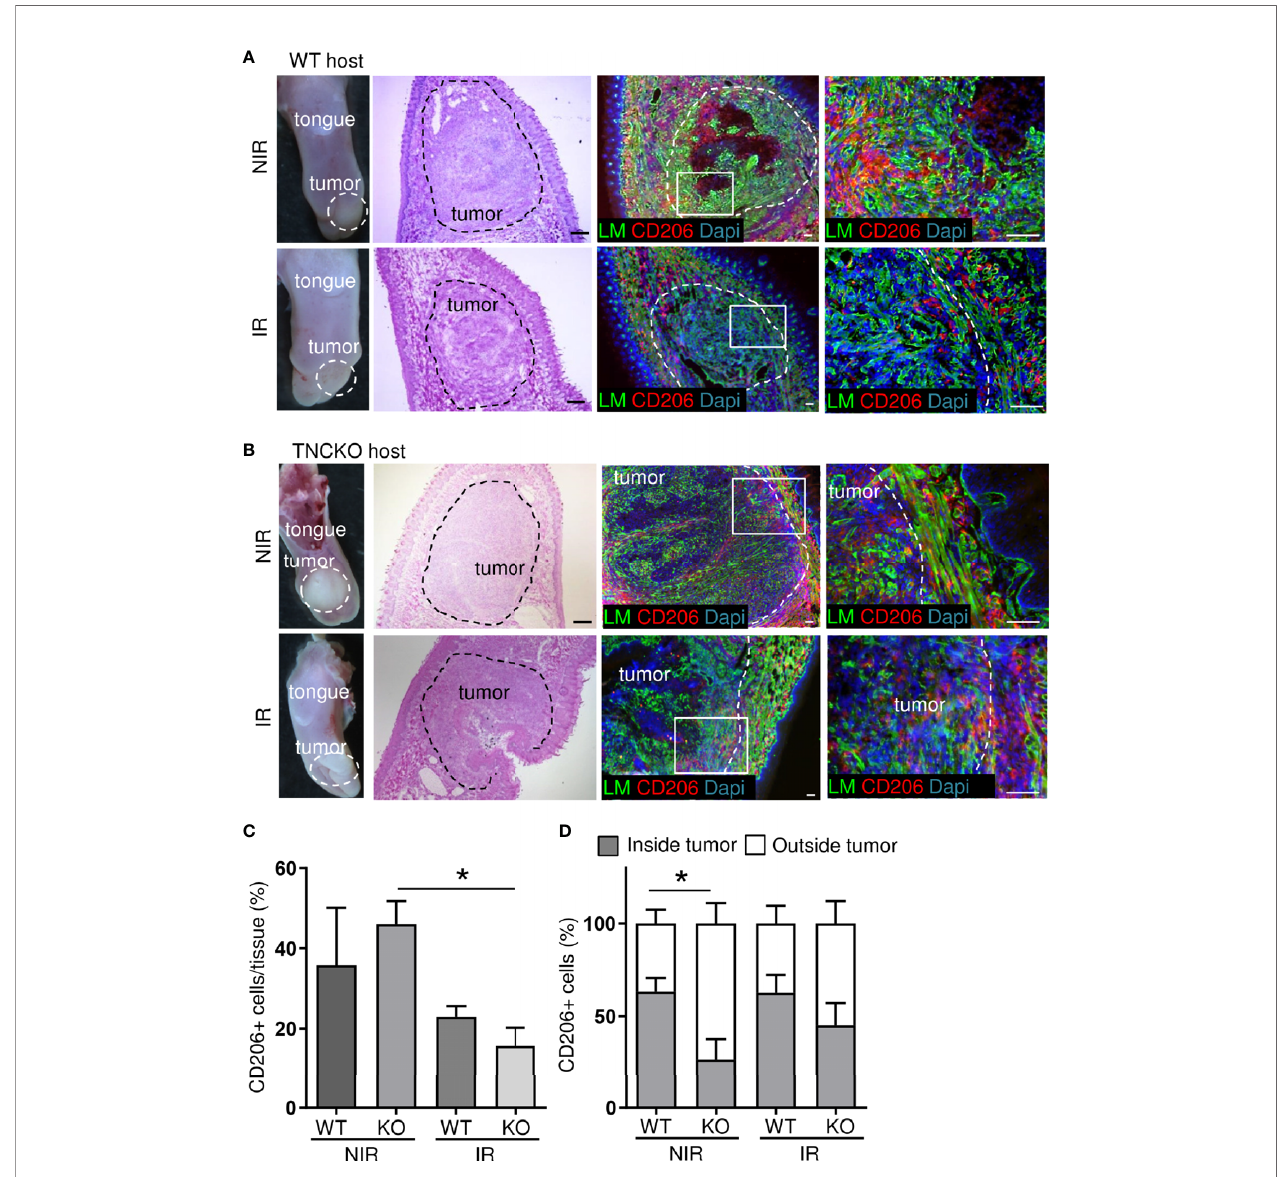
FIGURE 7 | Irradiation effects on CD206+ macrophages in OSCC13 tumors. Representative (N = 5) macroscopical images of H&E stained tongue tissue and immunostaining with speci fi c antibodies against laminin (LM, green) and CD206 (red) in OSCC13 tumors from WT (A) and TNCKO mice (B) . Scale bar, 100 µm. (C) Quanti fi cation of CD206+ cells in the tongue (referenced to DAPI signal) in percentage. N = 3, mean ± SEM, non-parametric ANOVA followed by Dunns post- test, *p < 0.05. (D) Relative distribution of CD206+ cells inside or outside the tumor of WT and TNCKO mice in non-irradiated (NIR) and irradiated (IR) conditions, respectively. N = 3, mean ± SEM, non-parametric ANOVA followed by Dunns post-test, *p <0.05. NIR, non-irradiated mice; IR, irradiated